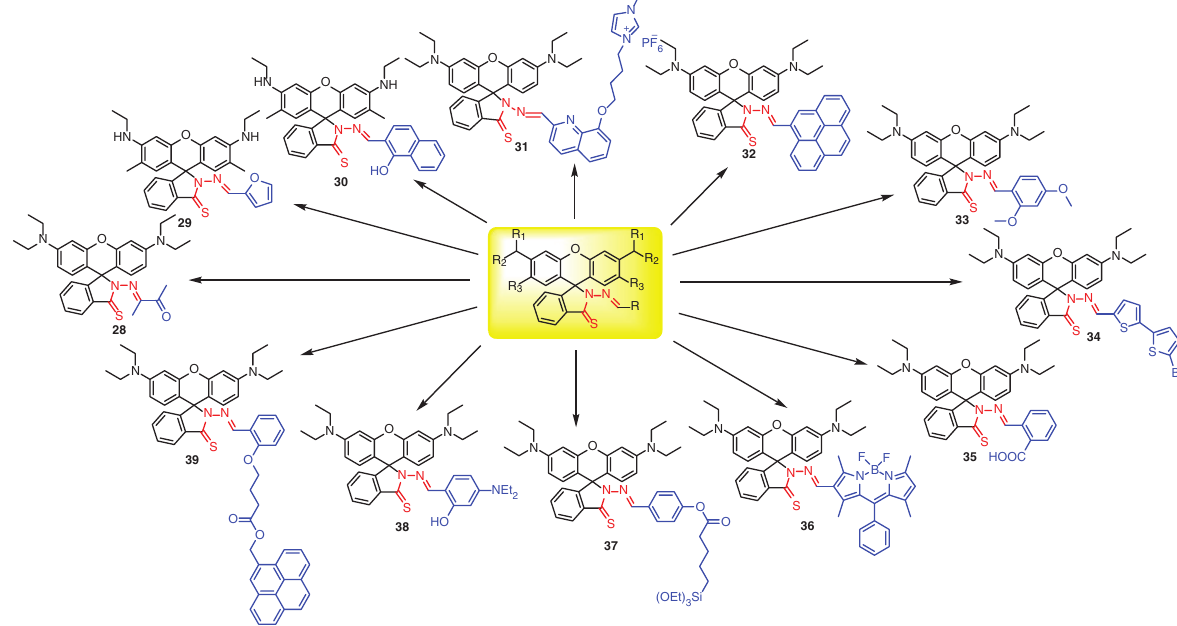
Figure 17: Probes based on rhodamine thiohydrazone for detecting Hg 2 +